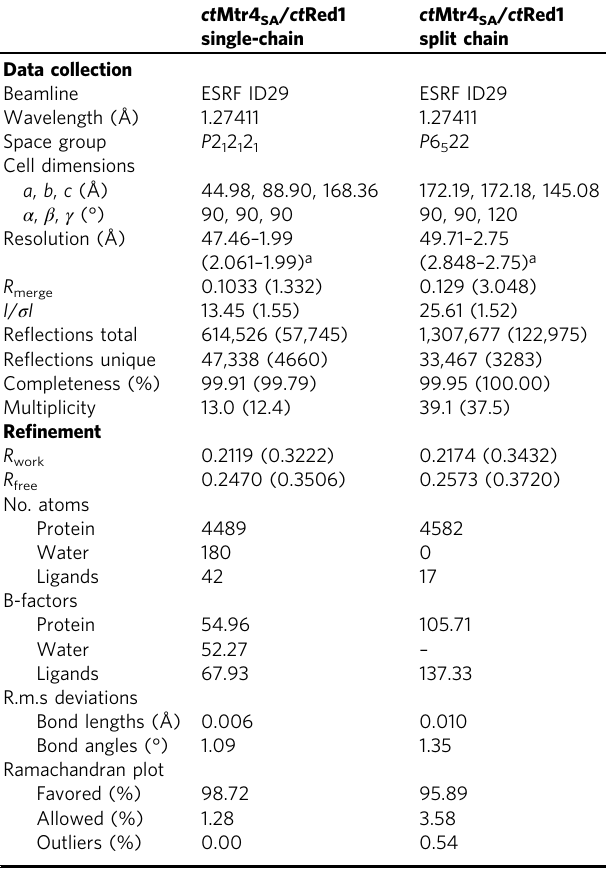
Table 1 Data collection and re fi nement